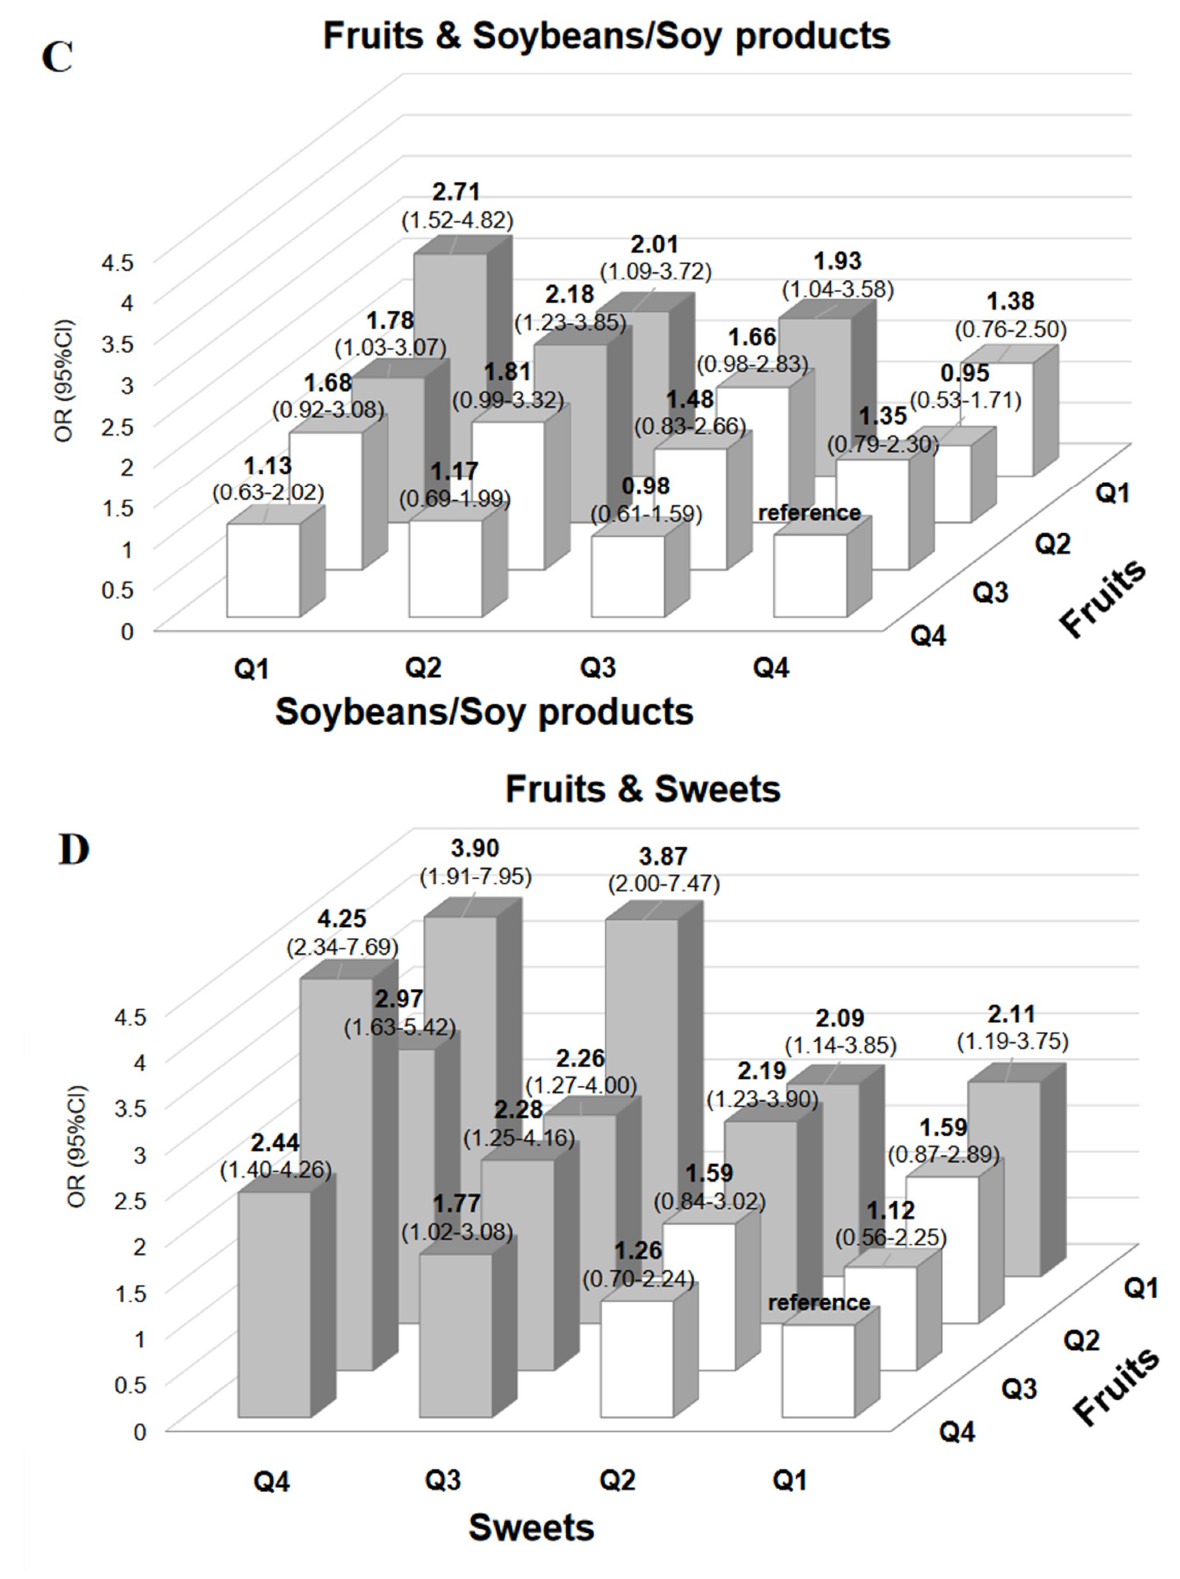
Figure 1. Odds ratios for obesity for four combinations of quartiles of each of food groups. ( A ). Odds ratios for obesity according to the combination of vegetables and fruits in quartiles by multi-logistic regression analysis. To investigate the interaction between vegetables and fruits in relation to obesity, 16 groups were formed by combining vegetables and fruits by quartiles. Multiple logistic regression analysis was used to investigate the odds ratios (OR) for obesity, with the reference group being the top quartile. ( B ). Odds ratios for obesity according to the combination of vegetables and soybeans/soy products in quar- tiles by multi-logistic regression analysis. To investigate the interaction between vegeta- bles and soybeans/soy products in relation to obesity, 16 groups were formed by combin- ing vegetables and soybeans/soy products by quartiles. Multiple logistic regression anal- ysis was used to investigate the odds ratios (OR) for obesity, with the reference group being the top quartile. ( C ). Odds ratios for obesity according to the combination of fruits and soybeans/soy products in quartiles by multi-logistic regression analysis. To investi- gate the interaction between fruits and soybeans/soy products in relation to obesity, 16 groups were formed by combining fruits and soybeans/soy products by quartile. Multiple logistic regression analysis was used to investigate the odds ratios (OR) for obesity, with the reference group being the top quartile. ( D ). Odds ratios for obesity according to the combination of fruits and sweets in quartiles by multi-logistic regression analysis. To in- vestigate the interaction between fruits and sweets in relation to obesity, 16 groups were formed by combining fruits and sweets by quartiles. Multiple logistic regression analysis was used to investigate the odds ratios (OR) for obesity, with the reference group for fruits being the top quantile and that for sweets being the bottom quantile. Total vegetables and fruits comprised the combination with the highest association with obesity; the OR for obesity for the lowest quartiles of these food groups was 3.9. However, the ORs for obesity were significantly increased even for the combination of